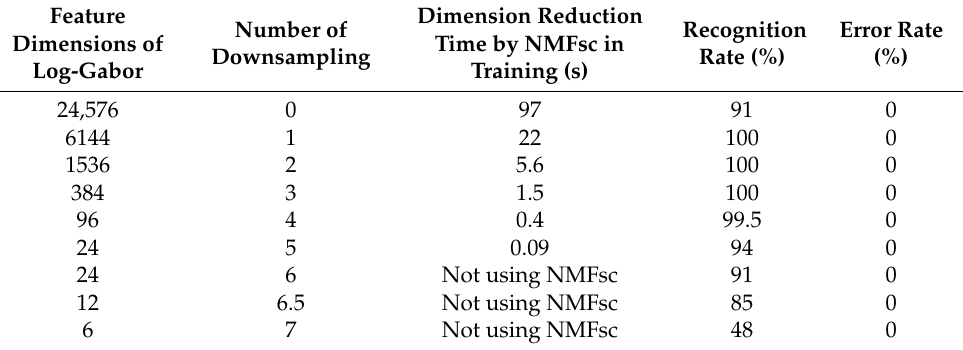
Table 2. Experimental results of Log-Gabor feature downsampling and